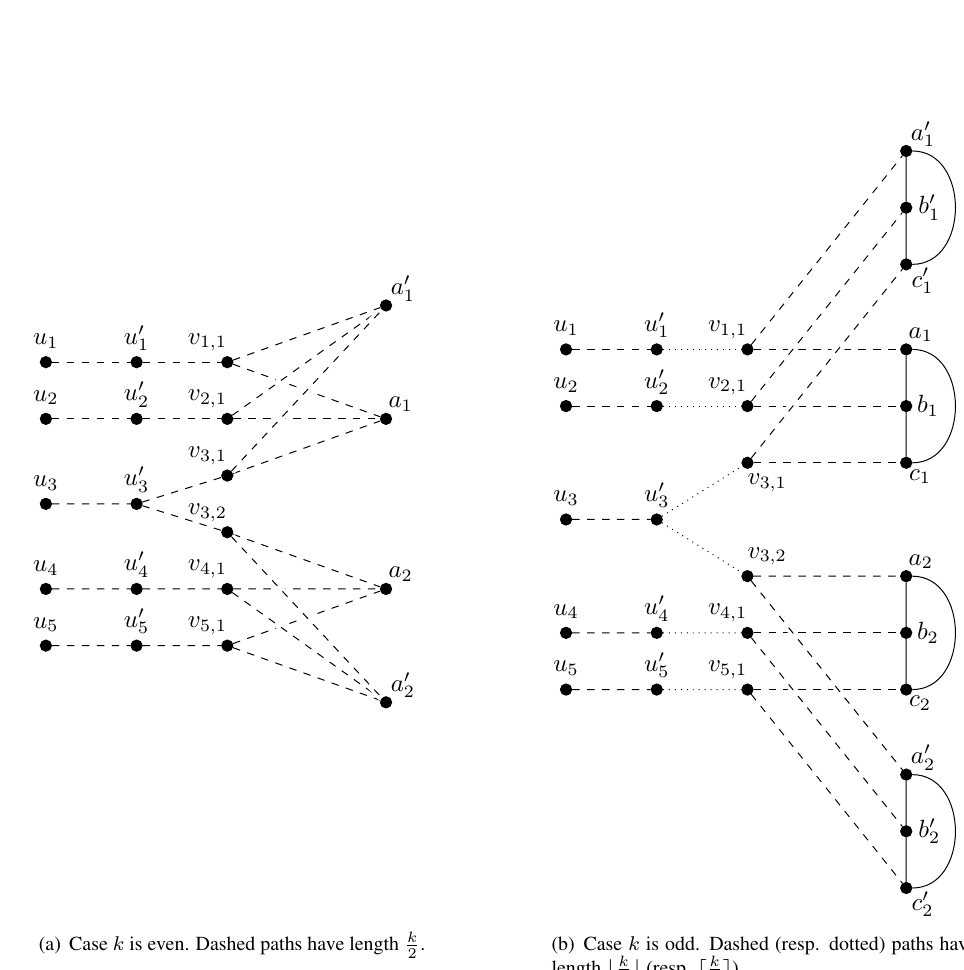
Figure 1: The crux subgraph G c { x 3 , x 4 , x 5 }